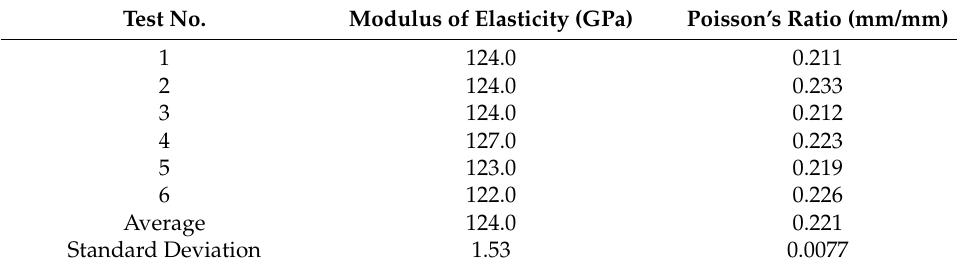
Table 6. Equivalent properties of Specimen Type II